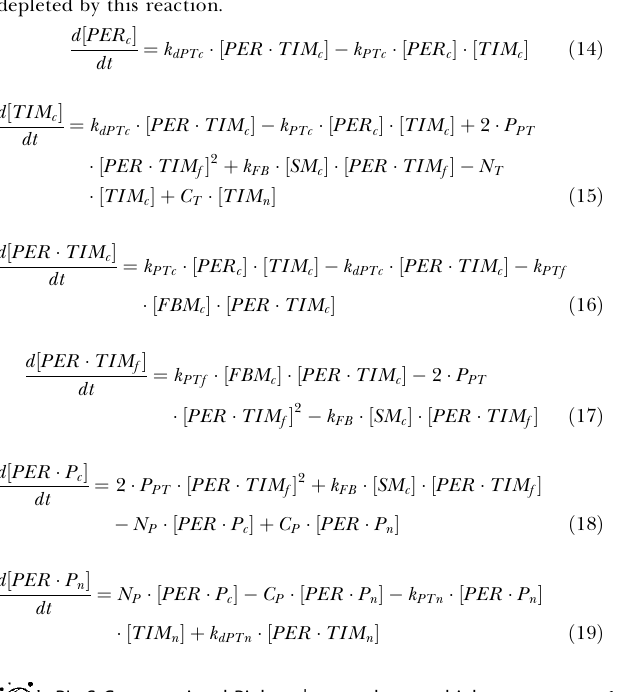
PLoS Computational Biology |